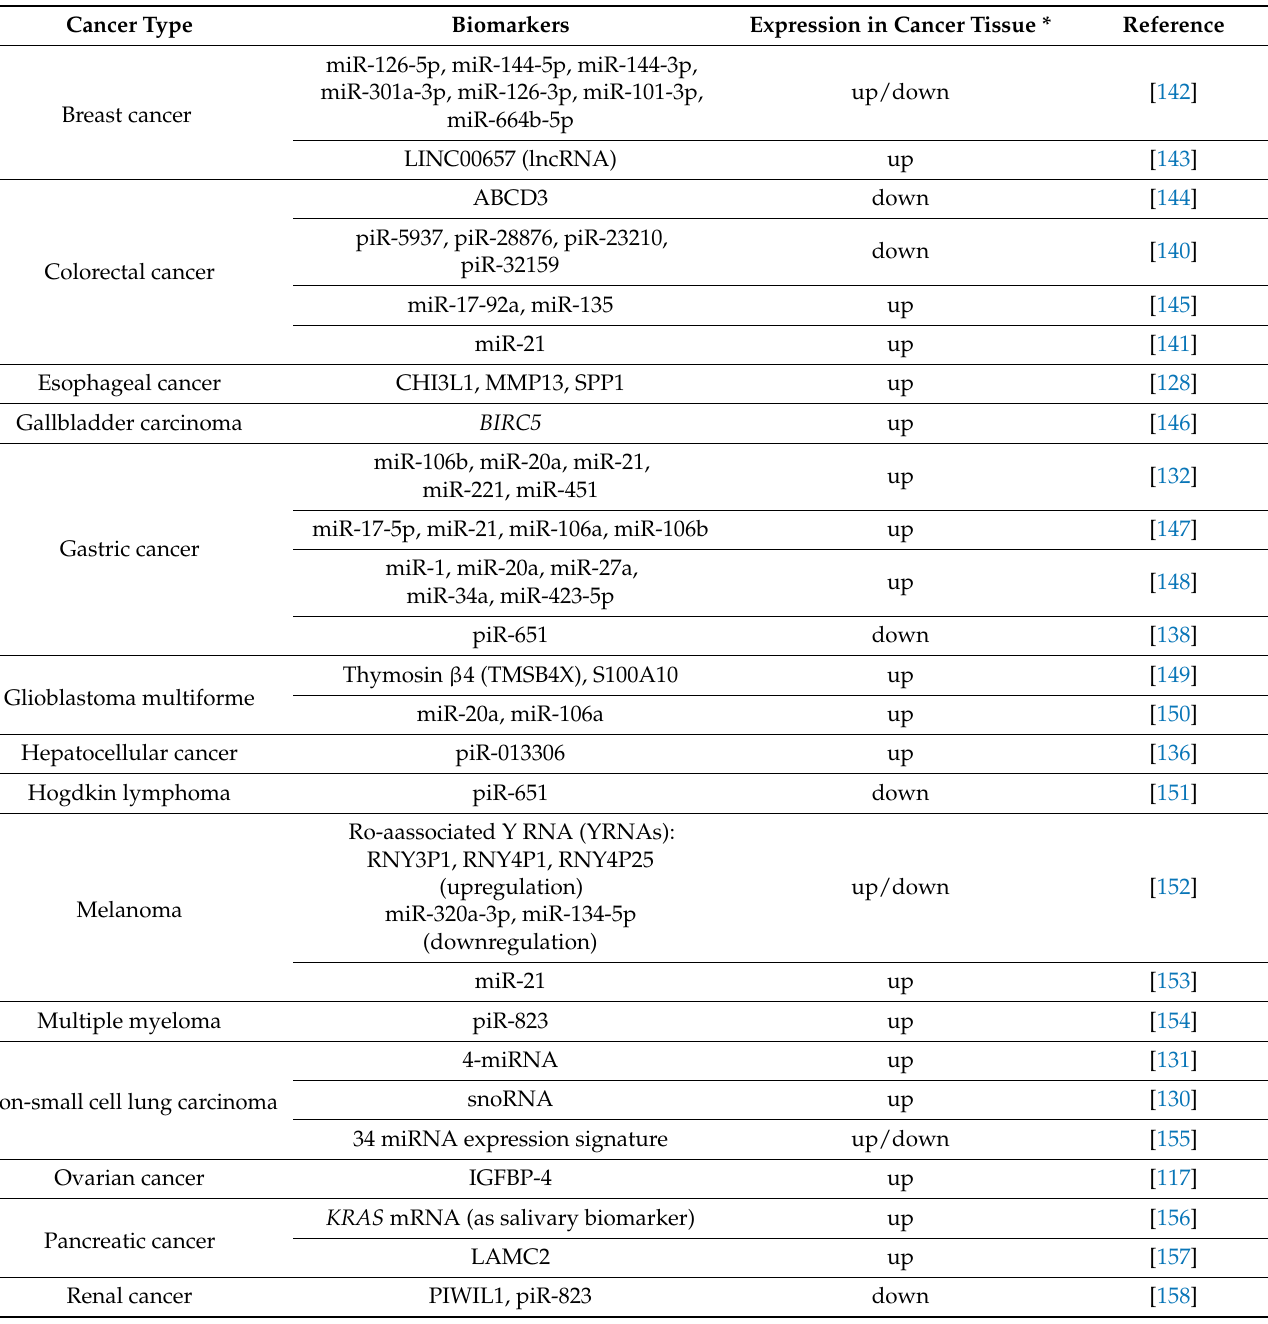
Table 2. Potential cancer biomarkers discovered through transcriptome